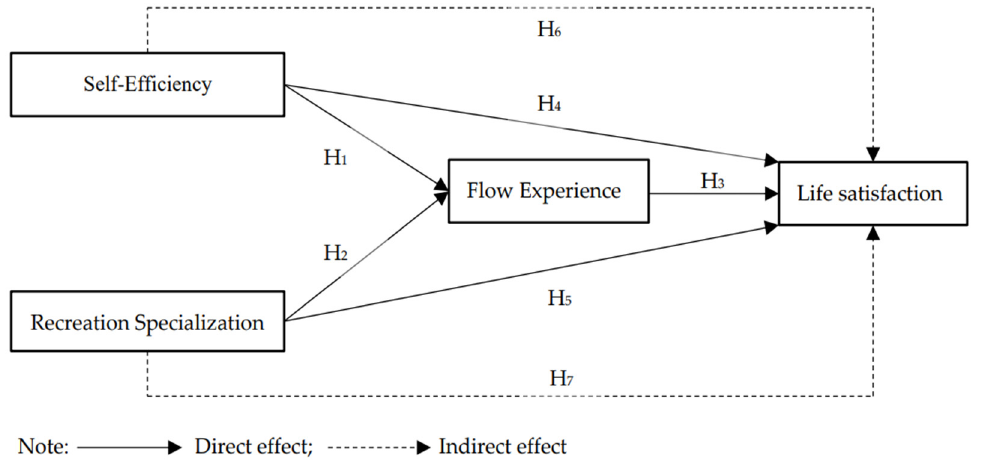
Figure 1. Proposed conceptual model.